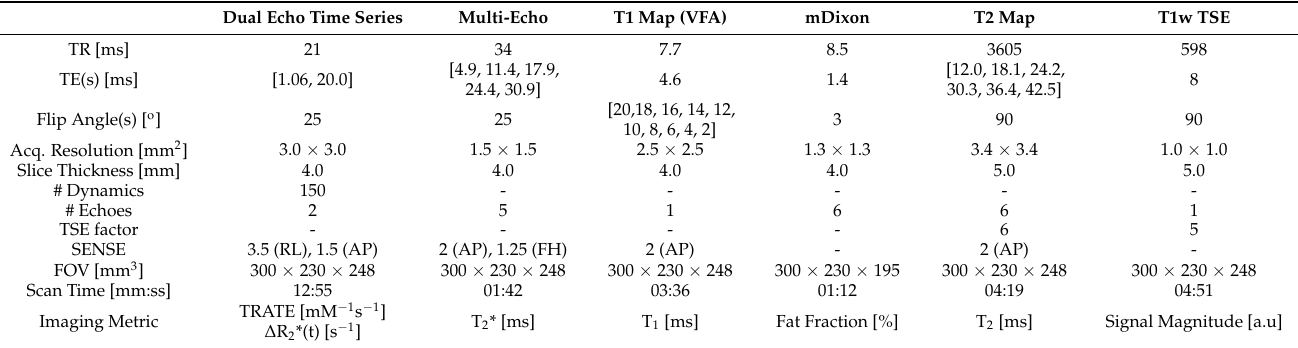
Table 1. List of select MRI acquisition parameters for each protocol of the exam.